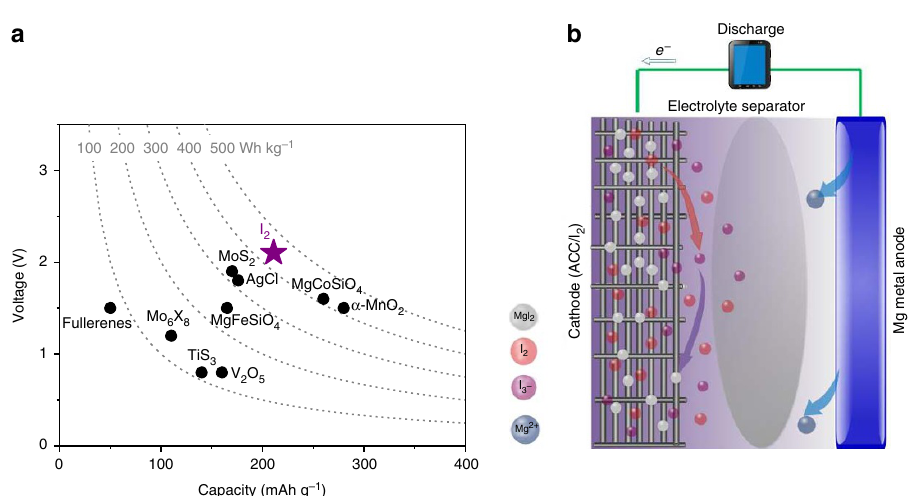
Figure 1 | Schematic illustration of the rechargeable magnesium/iodine battery. ( a ) The capacity and voltage of the iodine cathode compared with reported rechargeable magnesium batteries cathodes. ( b ) Schematic of rechargeable Mg/I 2 batteries. NATURE COMMUNICATIONS|8:14083|DOI: